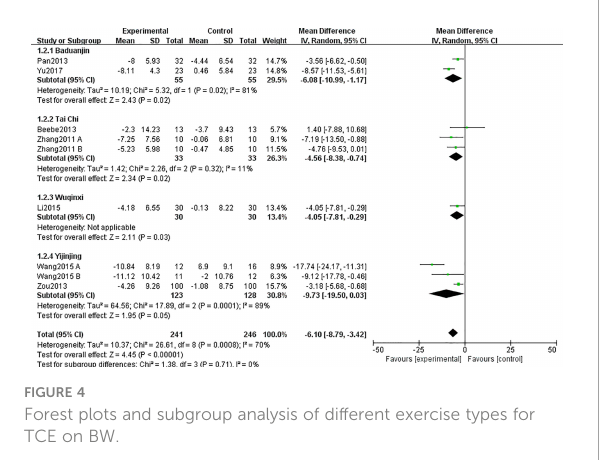
FIGURE 4 Forest plots and subgroup analysis of different exercise types for TCE on BW.